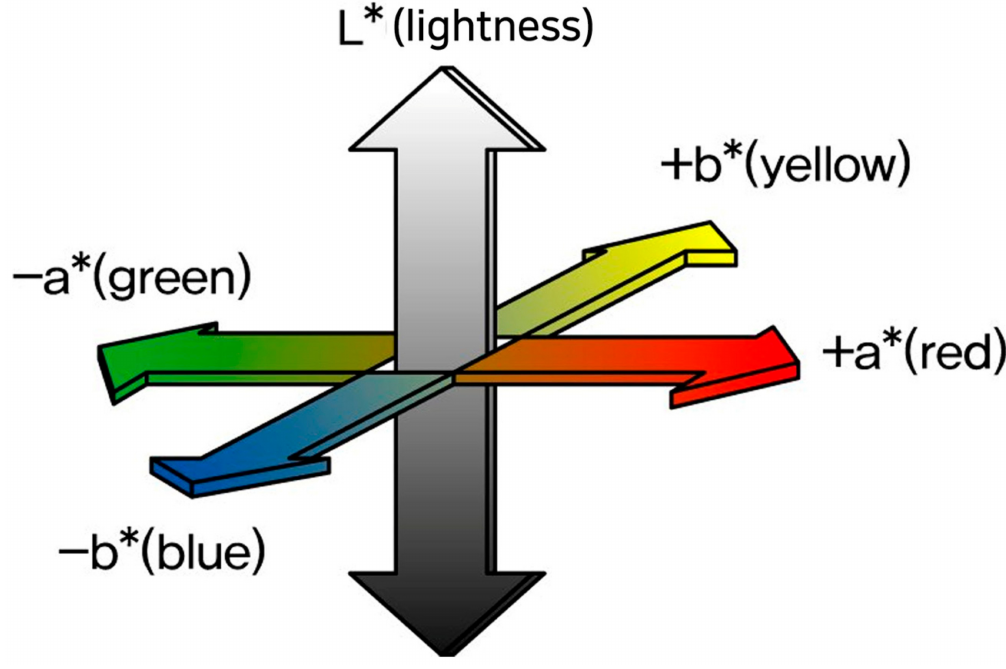
Figure 2. CIELAB color space (L* = lightness, a* = red to green, b* = yellow to blue). The CIELAB coordinate axes L* a* b* are stated as “L-star”, “a-star”, and